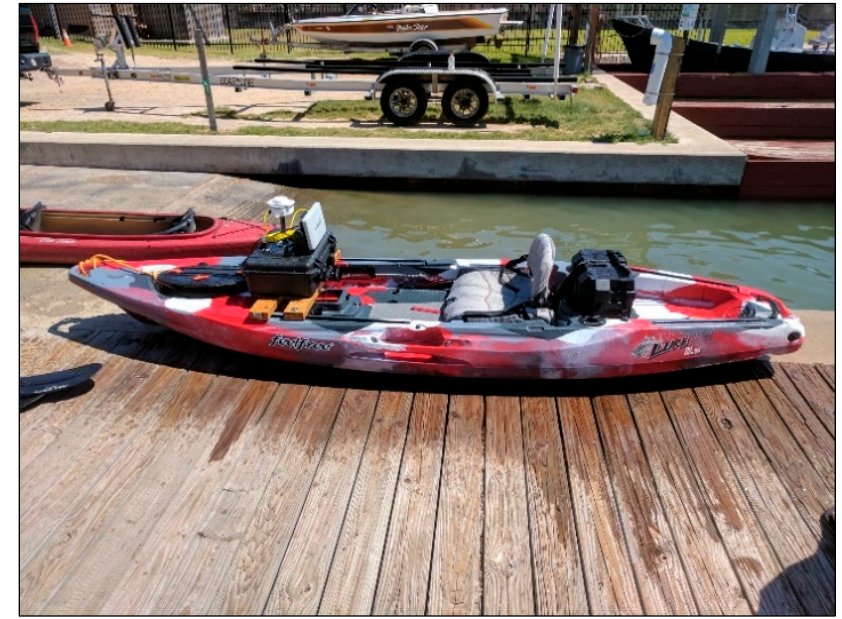
Figure 6. Kayak with sonar equipment.